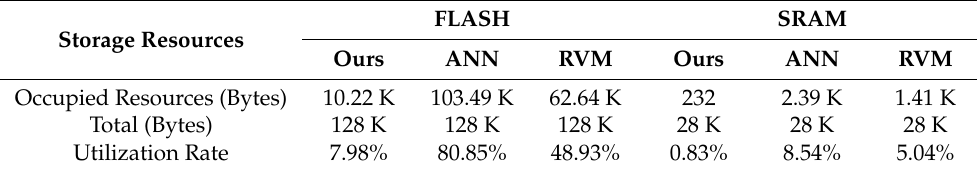
Table 13. Storage resource utilization of Self-Detection and Self-Calibration on